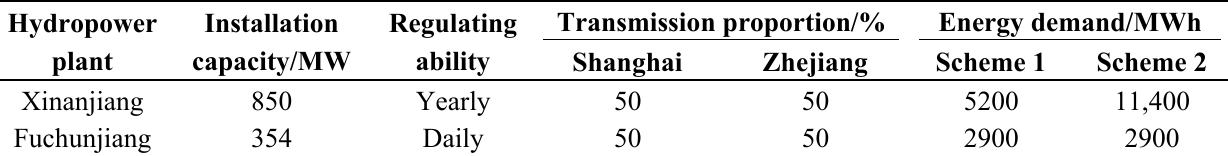
Table 1. Characteristics of cascaded hydropower plants built on the Xin-Fu